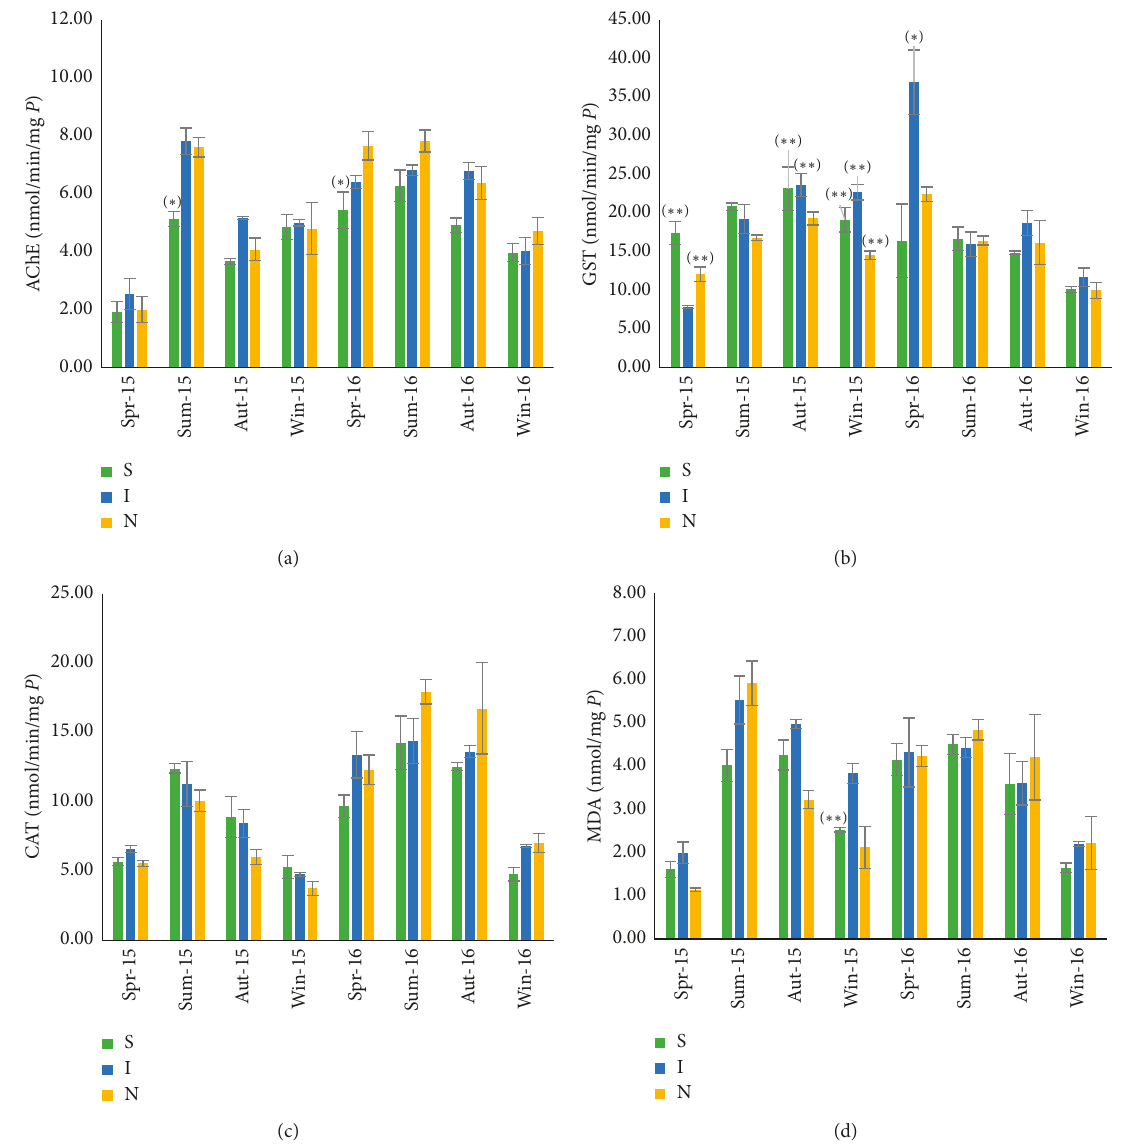
Figure 2: Seasonal variations of acetylcholinesterase (a), glutathione-S-transferase, (b), catalase activity, (c) and malondialdehyde level (d) in Mytilus galloprovincialis collected from 3 sites (South (S), Instal (I), and North (N)) of the coastline Cap Ghir (Spr: spring; Sum: summer; Aut: autumn; Win: winter). Data were expressed as mean ± SD ( n � 6). Values indicate significant difference between sites ( ∗ ) and between stations ( ∗∗ ), p < 0 .